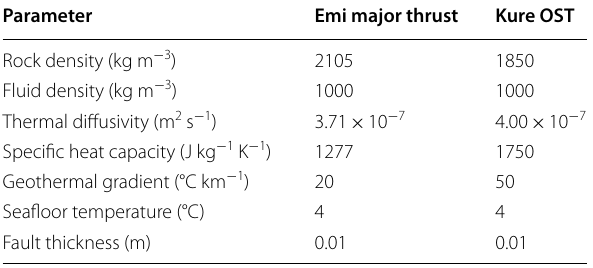
Parameters for the Emi major thrust and the Kure OST are from Hamada et al. (2011) and Kaneki et al. (2016), respectively